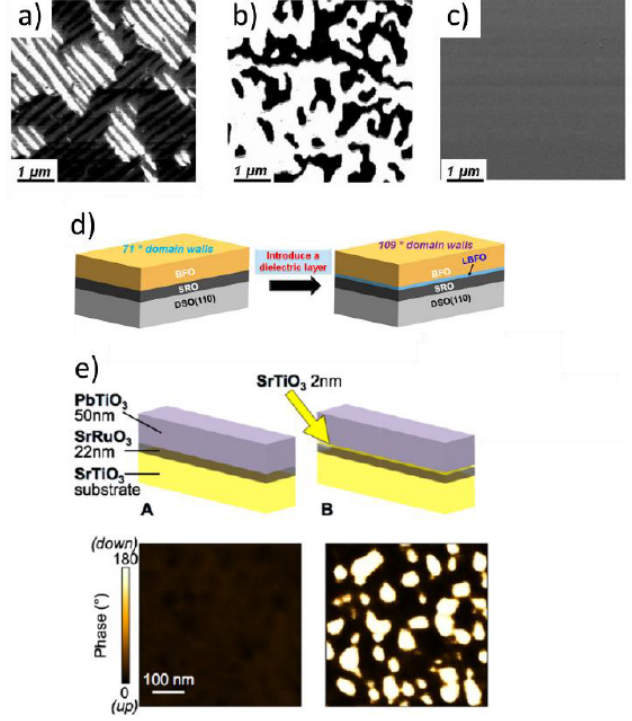
Figure 2. Domain engineering in ferroic thin films. ( a – c ) Control of the number of ferroelectric variants in BFO using STO substrate orientation. (001), (110) and (111) orientations correspond to ( a – c ), respectively. Reproduced with permission from [52], Copyright Wiley-VCH Verlag GmbH and Co. KGaA, 2007); ( d ) The insertion of a dielectric ultrathin lanthanum-doped BFO layer between